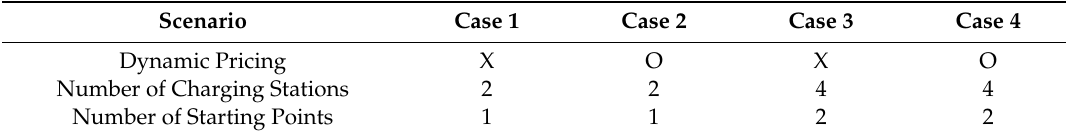
Table 1. The simulation scenario with dynamic pricing.